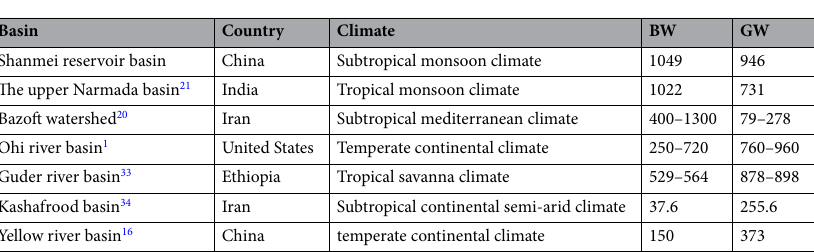
Table 3. Comparisons of annual average values or ranges of BW (mm) and GW (mm) at different climate basins around the world.